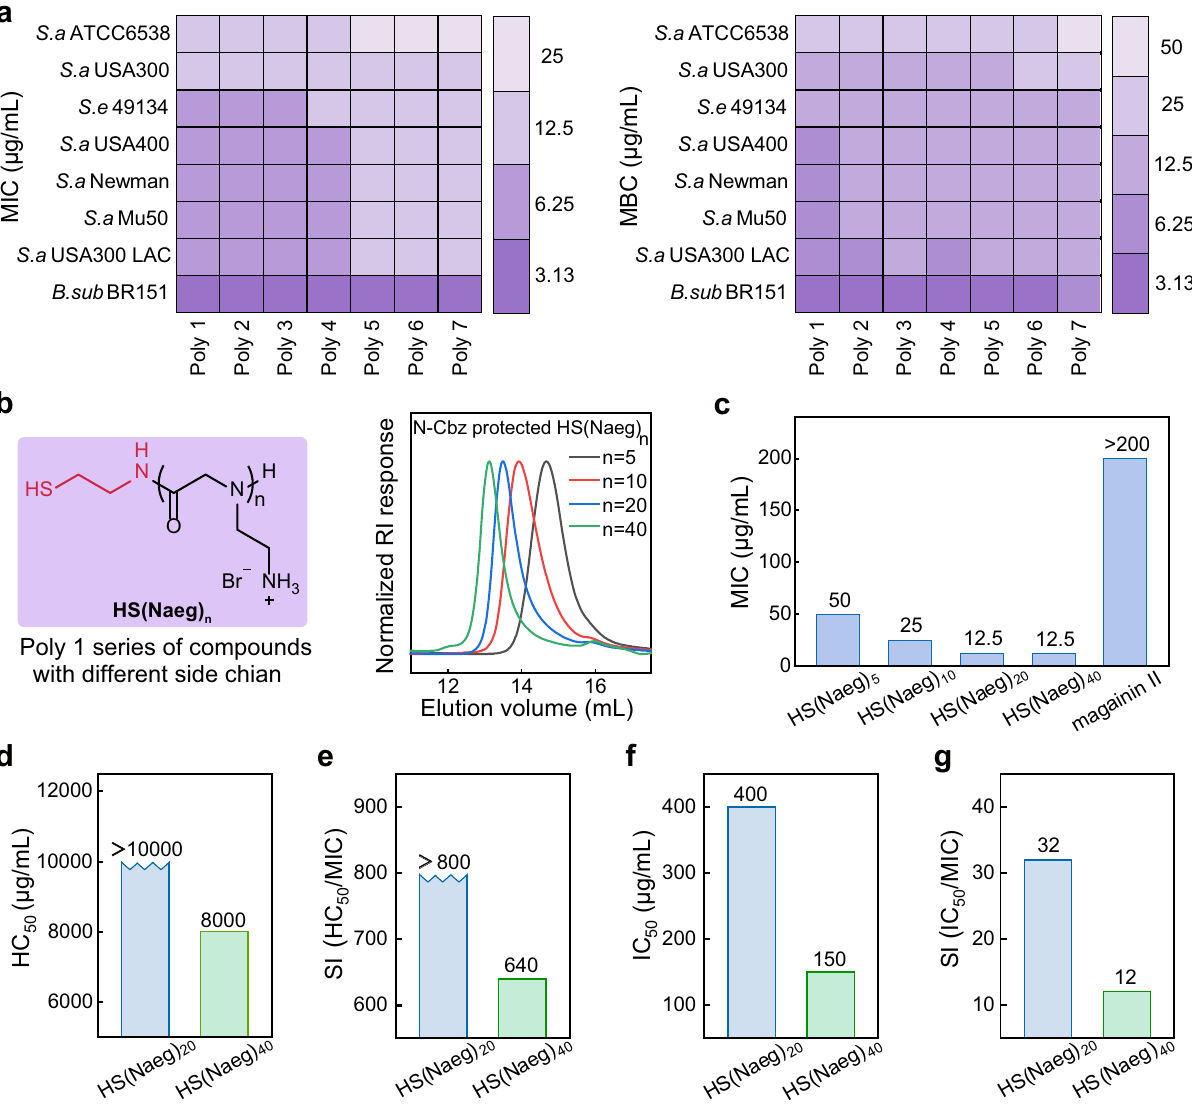
Fig. 2 Poly- α -peptoids displayed an excellent in vitro antibacterial pro fi le. a Antibacterial activity of Poly- α -peptoids. b Chemical structure of HS(Naeg) n and GPC characterization of N -Cbz protected HS(Naeg) n ( n = 5, 10, 20, 40). c MIC values of HS(Naeg) n , at variable chain length, against S. aureus ATCC6538 using magainin II for comparison. d Hemolysis of HS(Naeg) 20 and HS(Naeg) 40 on human red blood cells. e Selectivity index calculated from HC 50 /MIC. f Cytotoxicity of HS(Naeg) 20 and HS(Naeg) 40 on fi broblast cells. g Selectivity index calculated from IC 50 cytoplasm directly from ~400 s without strong enrichment on the cell membrane and without PI signal (Fig. 3b, c), which echoed the weak membrane depolarization conclusion above and implied an antimicrobial mechanism without strong direct interactions between the polymer and bacteria membrane. We hypothesize that peptoid polymer penetrates membrane possibly through direct translocation like some cationic antimicrobial peptides reported in precedent literature: the interaction of the positively charged polymer with negatively charged components of bacteria membrane destabilizes the membrane bilayer, creating a trans- membrane channel, thereby allowing the peptoid polymer to enter the bacterial cells without the membrane lysis 55 . About 300 s after the peptide polymer enriched in the cytoplasm, PI got into the cytoplasm and indicated the damage of bacteria mem- brane (Fig. 3b, c), which was supported by the front view of the Z-stacked image con fi rming colocalization of polymer with PI within bacteria (Fig. 3d).